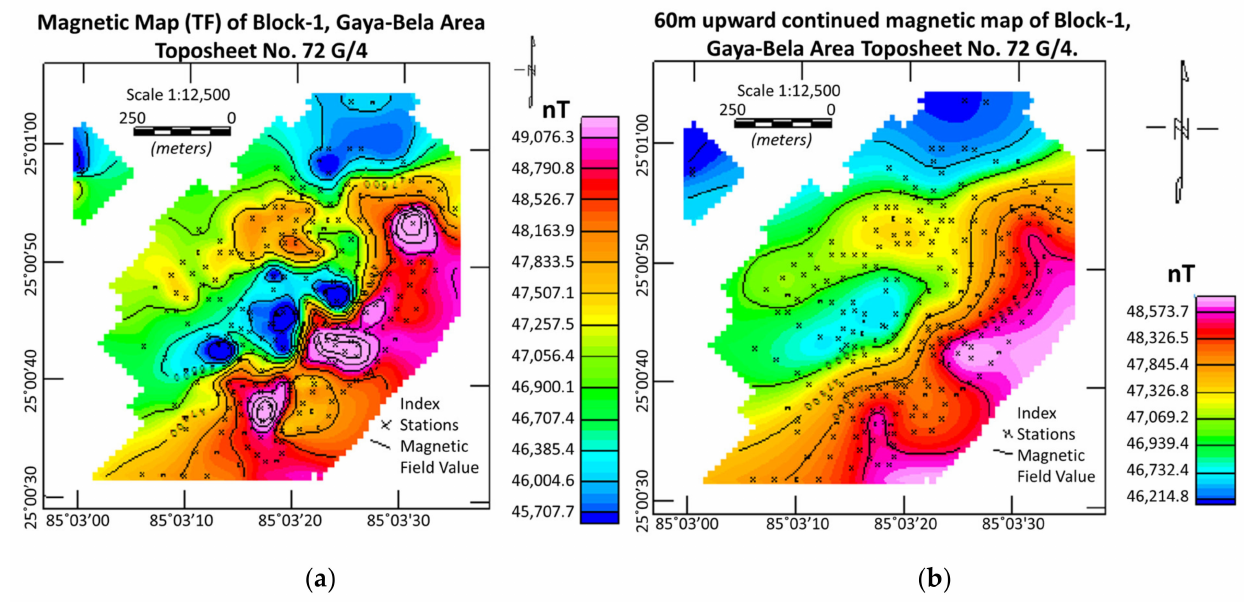
Figure 15. ( a ) Magnetic map (TF) of Block-1, and ( b ) Upward continued magnetic map of Block-1 [3]. The upward continuation technique was applied to enhance deeper features.